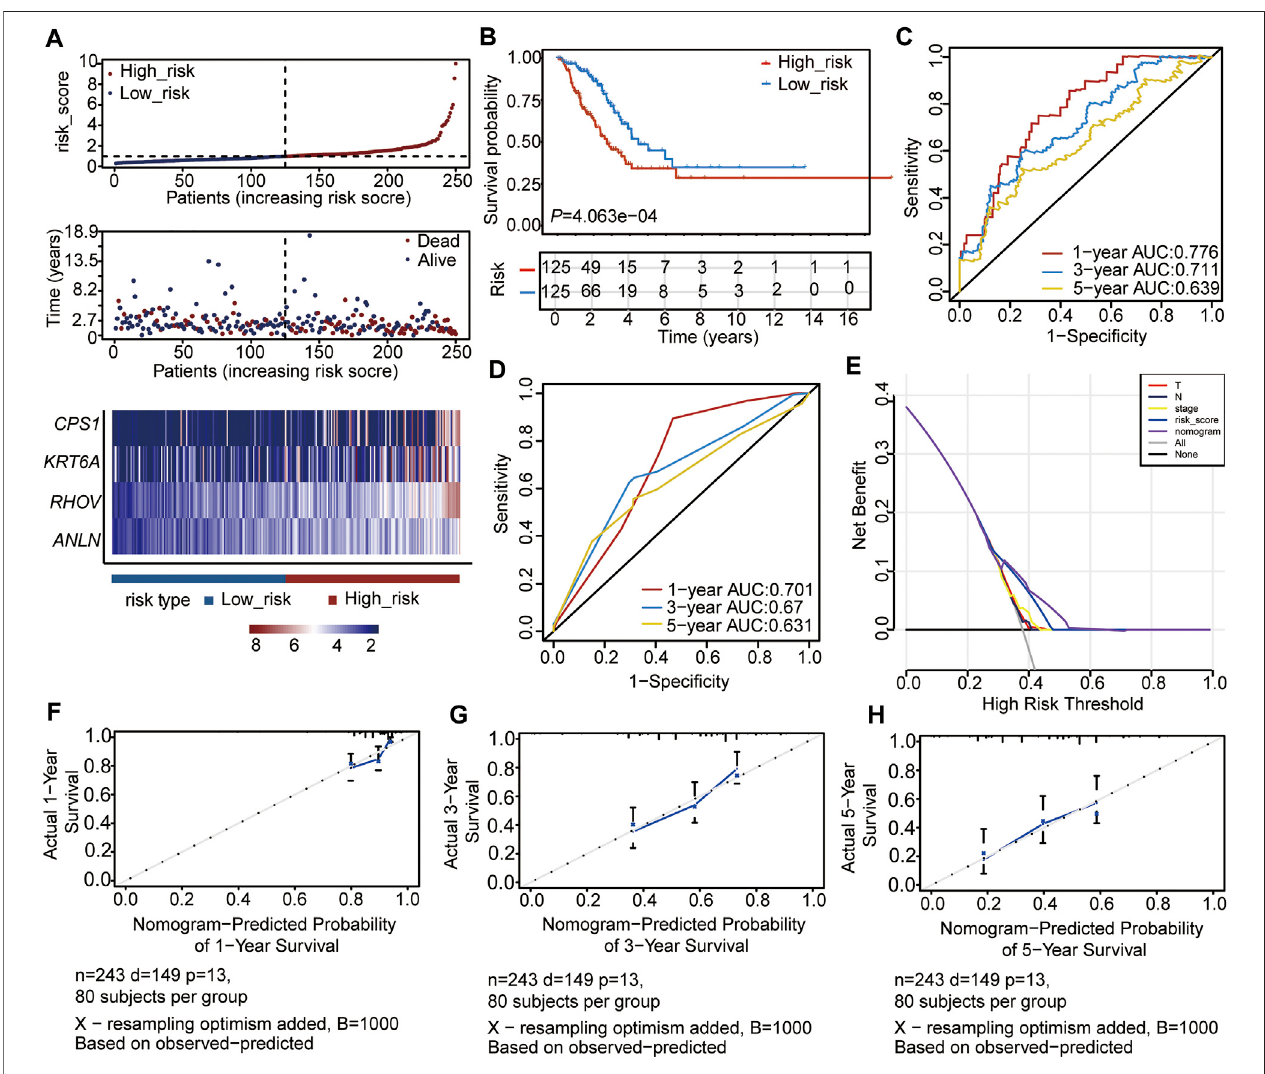
FIGURE5| ValidationoftheCoxmodelwithinternaldata. (A) Riskscoredistribution,survivalstatusofpatients,andheatmapofprognosticgenedistribution inthe validationset. (B) OSofhigh-andlow-riskgroups. (C) ROCcurveoftheCoxmodelfor1,3,and5years. (D) ROCcurveofthenomogrammodelfor1,3,and5years. (E) DCAresultofthenomogrammodel (F – H) Calibrationanalysisofthenomogrampredictedtheprobabilityof1-yearsurvival (F) ,3-yearsurvival (G) ,and5-yearsurvival (H) .